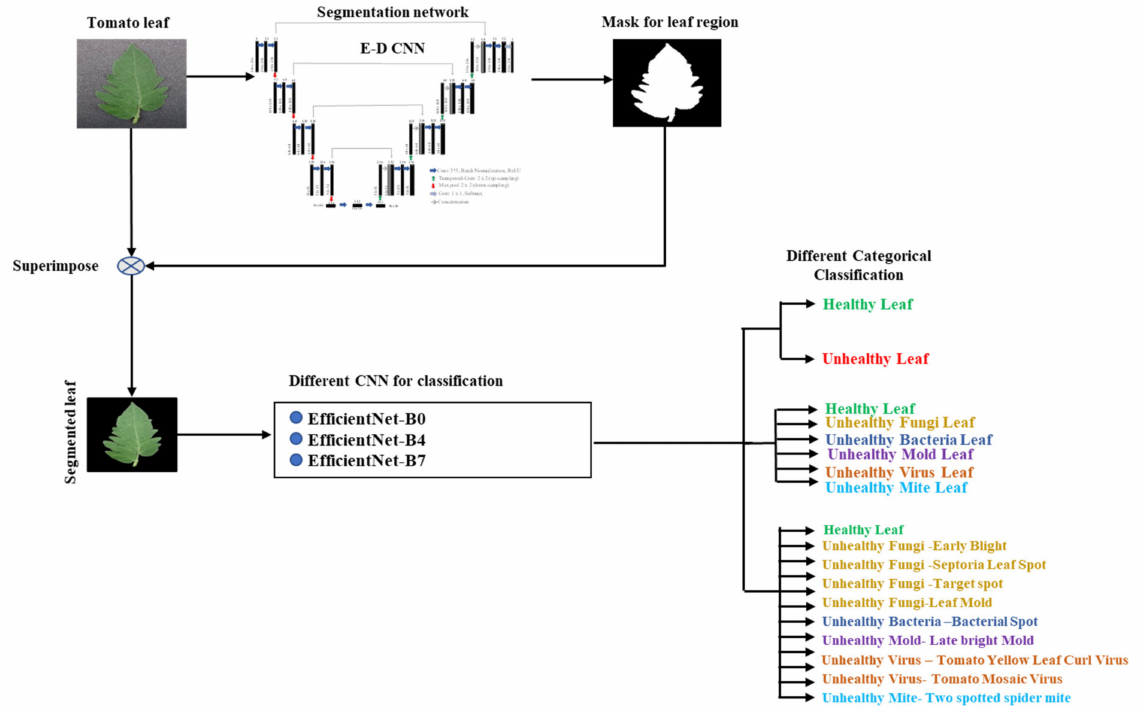
Figure 3. Overall Methodology of the